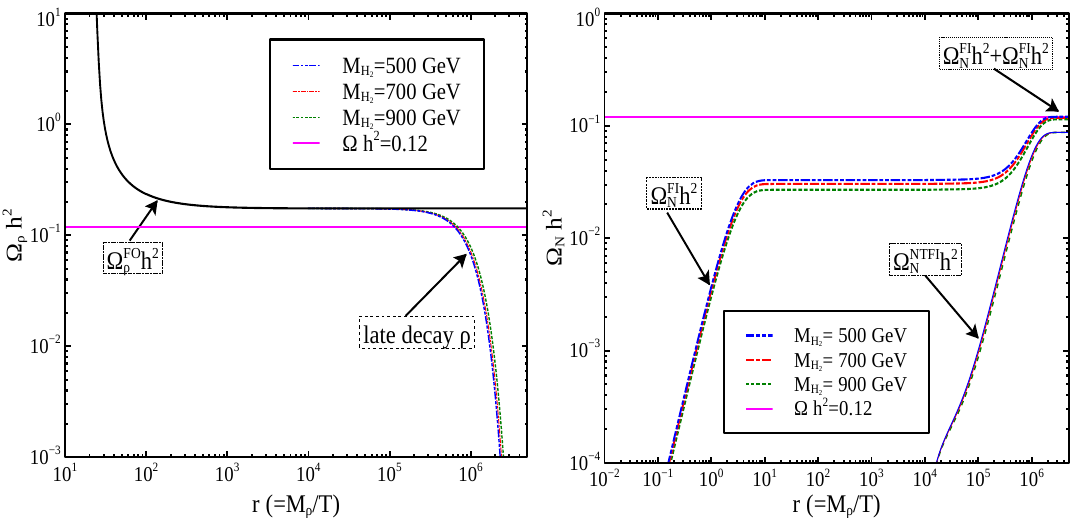
Figure 18 . Variation of the relic density of ρ (LP) and DM(RP) for the three different values of . In the RP, the contributions from thermal and non-thermal freeze-in are shown explicitly. M H 2 The model parameter are kept fixed to, M